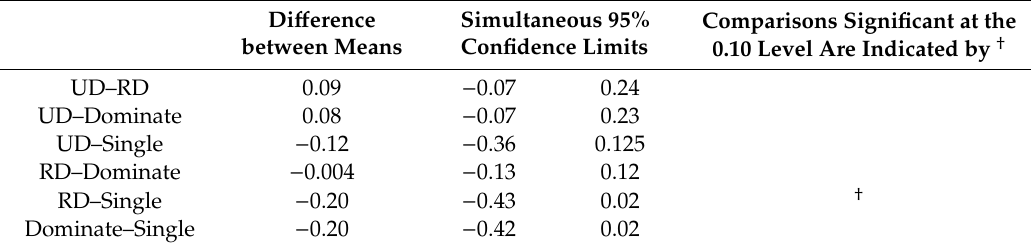
Table 6. A comparative Mean Risk Test—related to Diversification Groups.